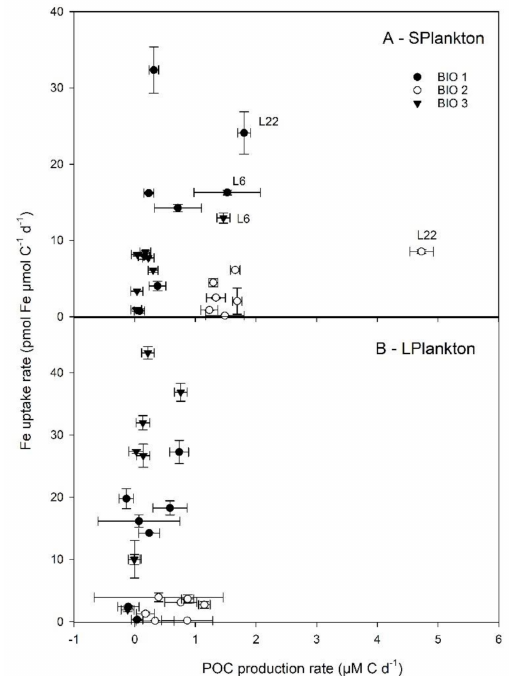
Figure 7. Relationship between Fe uptake rates and net daily POC production rates determined at the three stations following enrichment with Fe bound to di ff erent organic ligands. Data are shown for small (0.7–10 µ m, S-Plankton, A ) and large plankton ( > 10 µ m, L-Plankton, B ). Error bars indicate standard deviation ( n = 3–4).